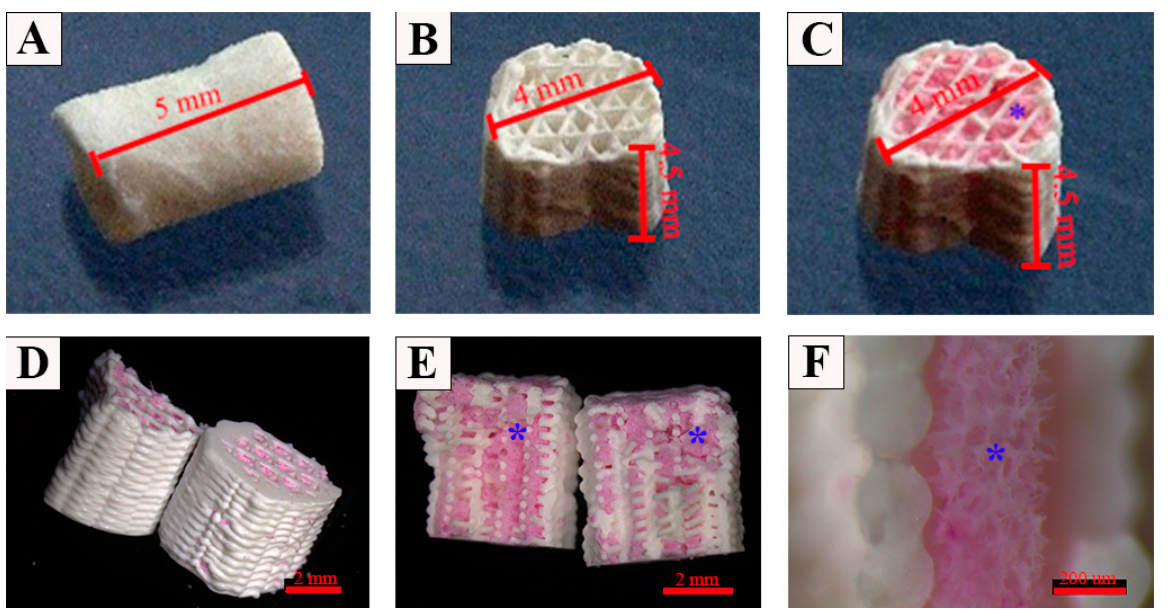
Figure 2. Appearance of scaffolds used for the treatment of the critical size femoral defects. ( A ) MCM scaffold; ( B ) CPC scaffold; ( C – F ) hybrid MCM-CPC scaffold (blue * : mineralized collagen matrix within 3D plotted CPC scaffolds stained with Sirius-red for better visualization).